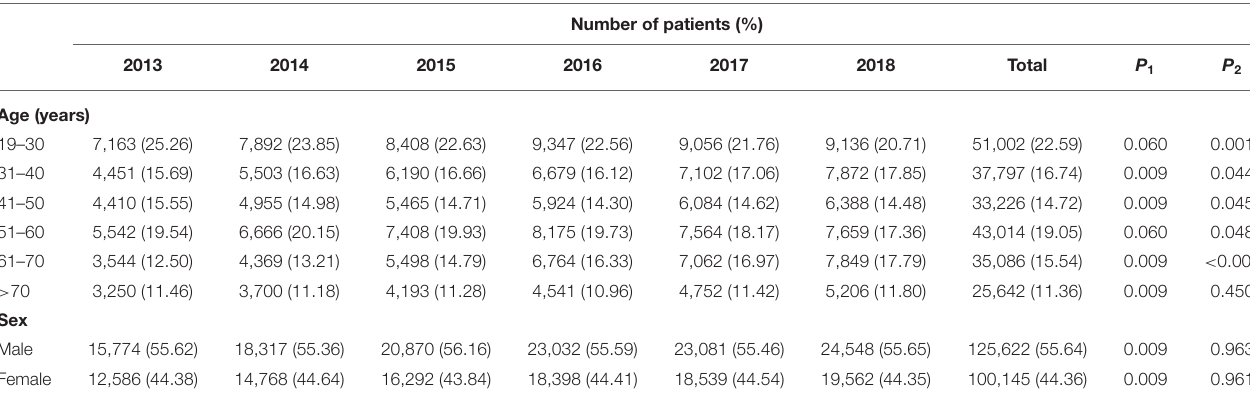
TABLE 1 | Demographic characteristics of study sample from 2013 to 2018.